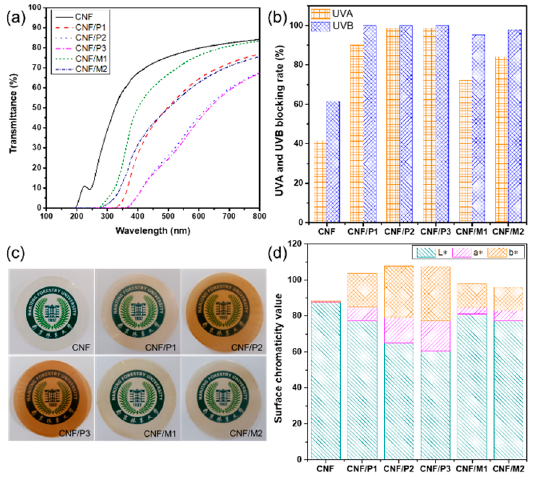
Figure 5. ( a ) The UV-vis transmission spectra of pure CNF film and different composite films. ( b ) UVA and UVB blocking rate of pure CNF film and different composite films. ( c ) Visual photograph of pure CNF film and different composite films. ( d ) Surface chromaticity value of pure CNF film and different composite films.